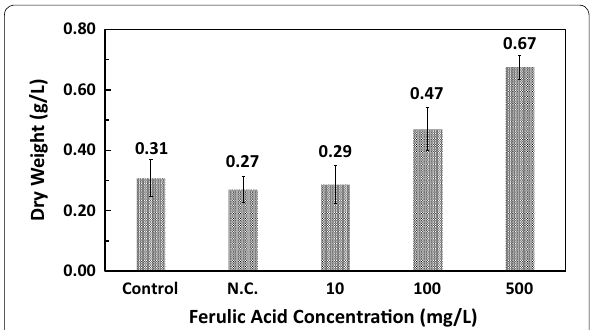
Fig. 2 Dry weight of Euglena gracilis with different concentrations of ferulic acid. N.C. negative control